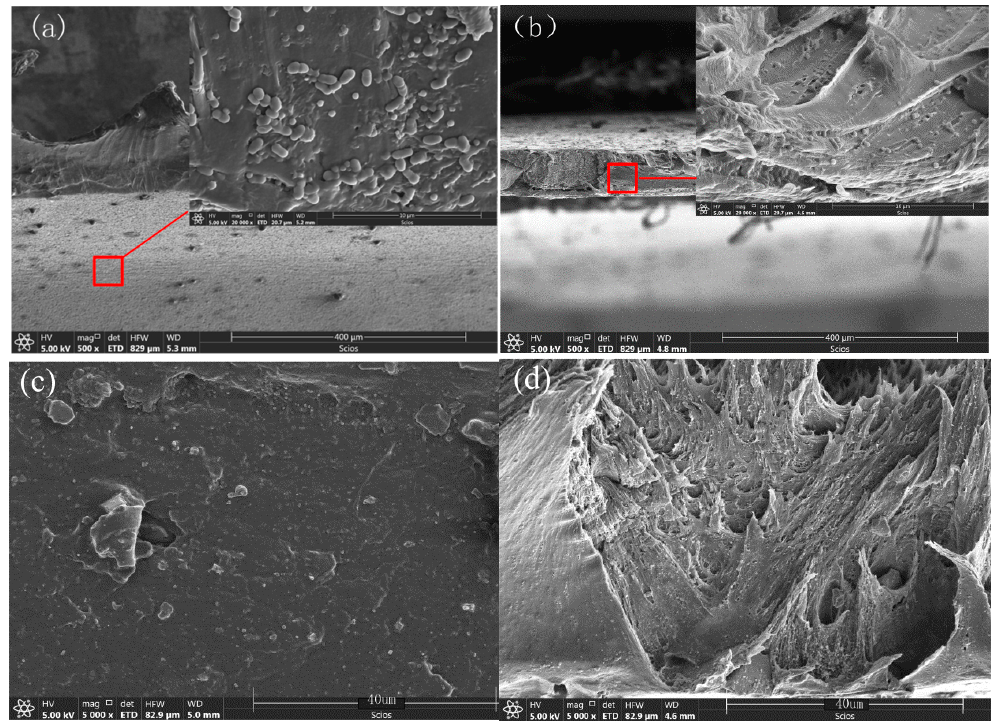
Figure9. SEMcross-sectionmicrographsofCB / SiO 2 / PVDFcomposites: ( a )2wt.%CB / 6wt.%SiO 2 / PVDF film; ( b ) 2 wt.% CB / 2 wt.% SiO 2 / PVDF film; ( c ) 6 wt.% CB / 4 wt.% SiO 2 / PVDF film; ( d ) 0.5 wt.% CB / 4 wt.% SiO 2 / PVDF